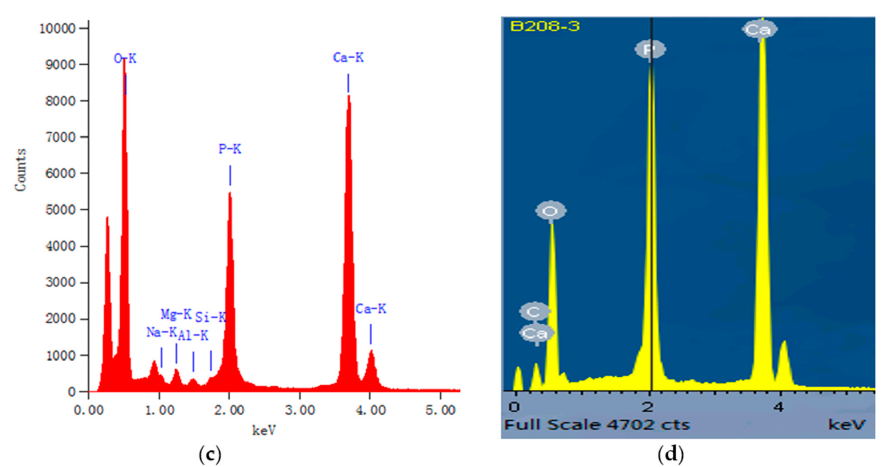
Figure 2. Lattice fringes and energy spectrum of hard tissues of Cololabis saira . ( a ) lattice fringe of HAP in bone, white lines mark domain sizes of hydroxylapatite on nanoscale; ( b ) details of two domain sizes in ( a ); ( c ) corresponding energy spectrum of ( a ); ( d ) energy spectrum of natural HAP in eclogite (sample B208) with Ca/P = 1.671 obtained by electron microprobe analysis (EMPA).